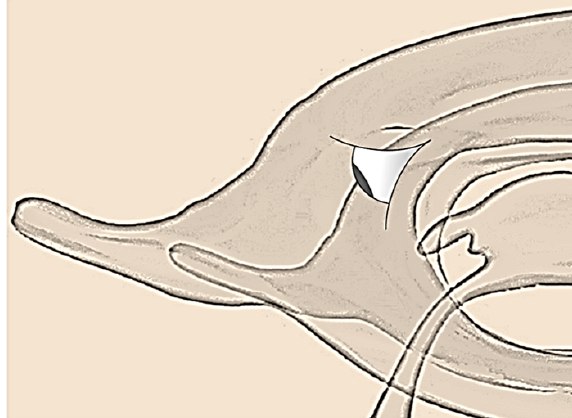
Fig. 11. Direction of the endoscopic viewing angle for ventricular atrium.